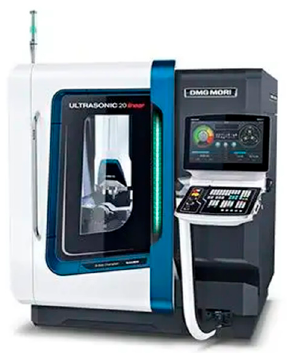
Figure 3. DMG Ultrasonic 20 linear high-speed machining center.